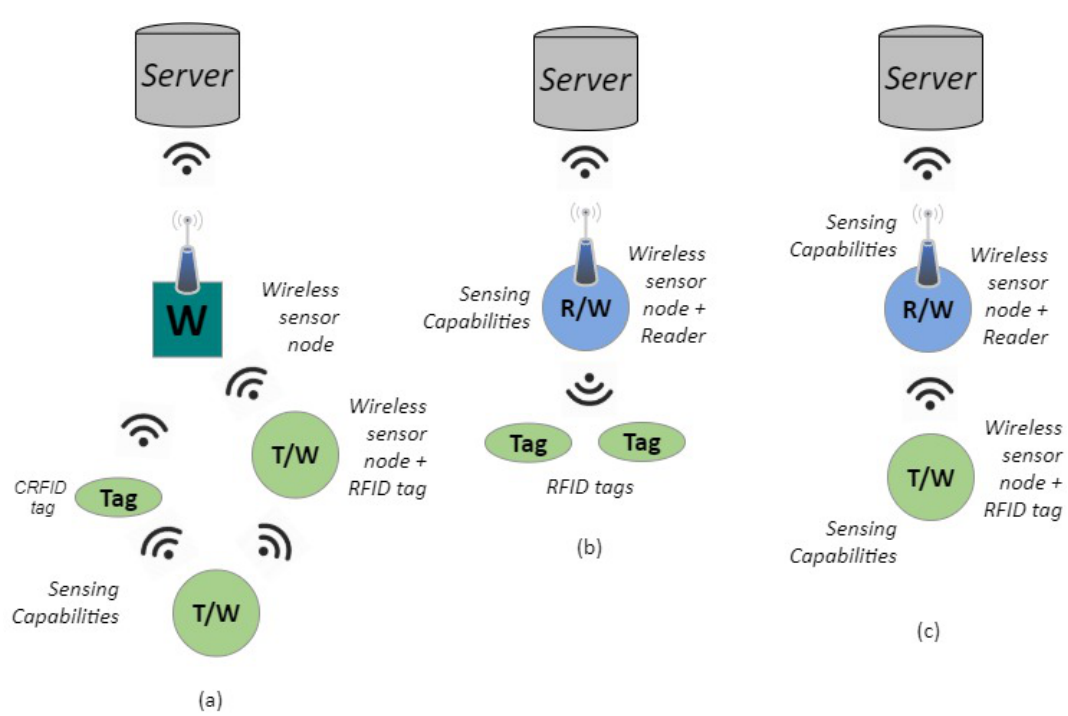
Figure 4. Types of integration in WSN and RFID: ( a ) at tag level, ( b ) at reader level, ( c )